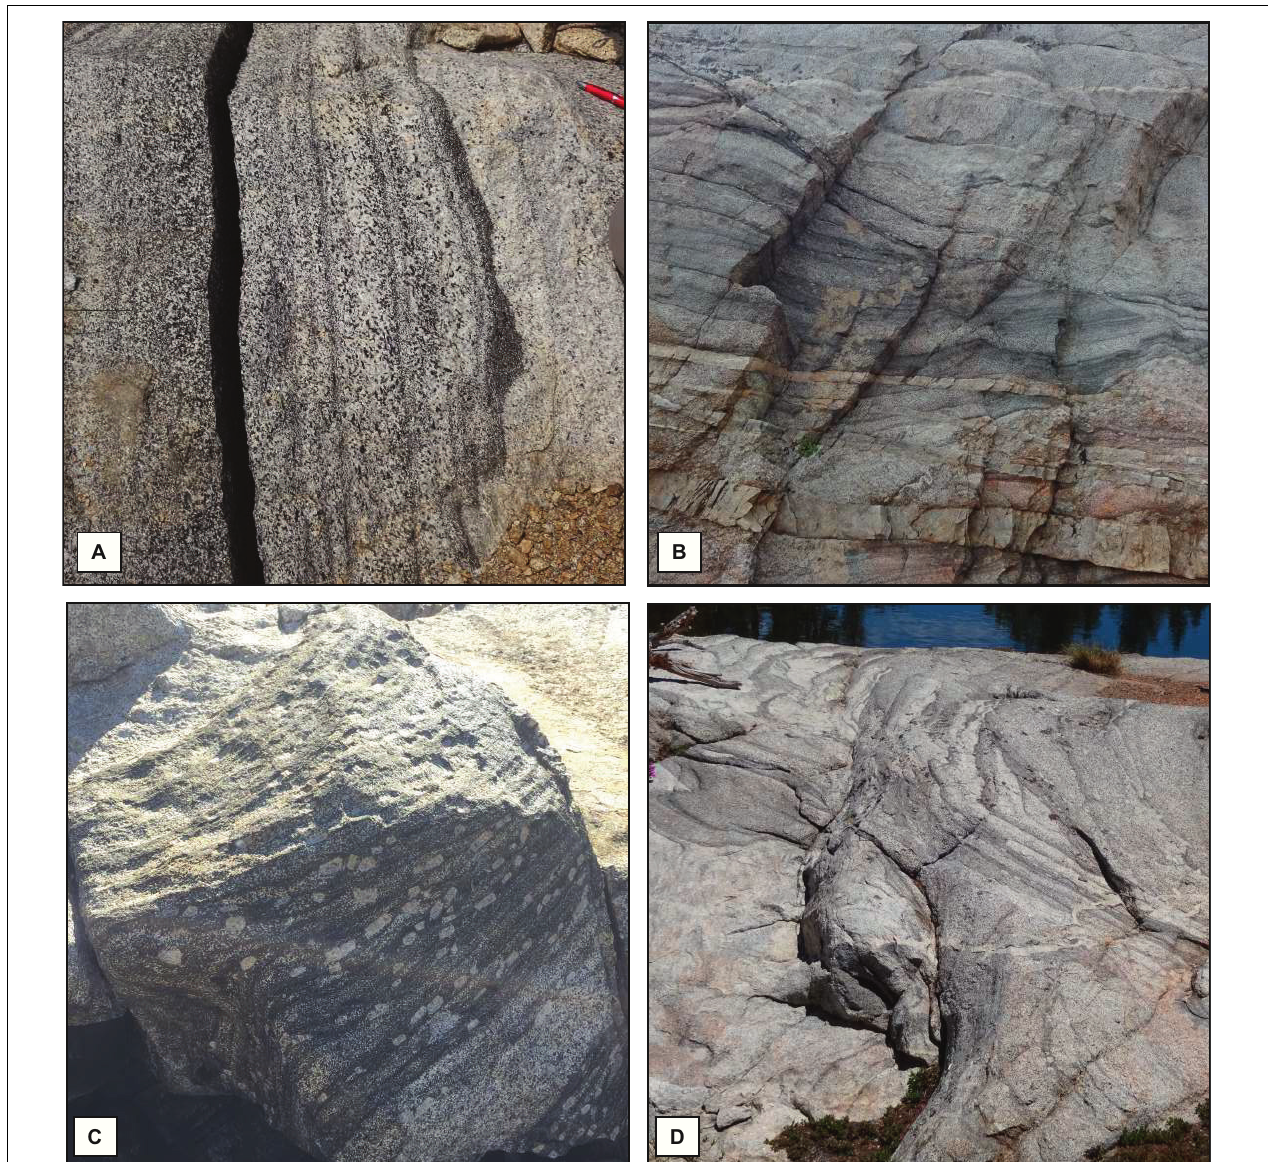
FIGURE 3 | Field photos of planar schlieren and trough structures. (A) Modally and grain-size graded schlieren layering in eHD, Sawmill Canyon area. Layers have a sharp, fine-grained base, and increase in grain size while reducing the amount of hornblende and biotite towards the right of the photo before the next layer forms. Pen for scale. (B) Erosion and redeposition of schlieren trough packages in CP at Sawmill Canyon. The package is upward-younging, and locally contains K-feldspar megacrysts. Leucogranite dikes cut the entire section. (C) Megacryst-bearing schlieren troughs showing low-angle truncation. Photo courtesy of J. McColl. (D) Complex schlieren trough packages with interlayered felsic material that is distinct from the surrounding host. Sawmill Canyon area.